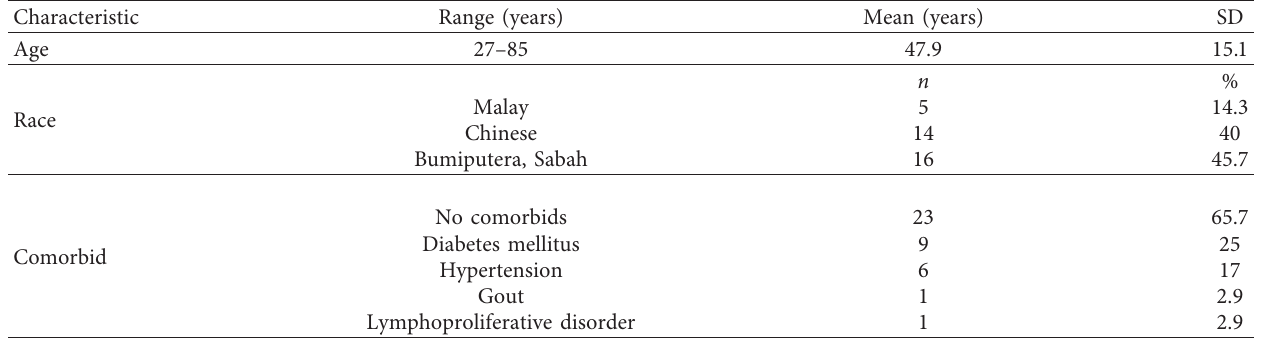
Table 1: Demographic data of patients who received musculoskeletal steroid injections.